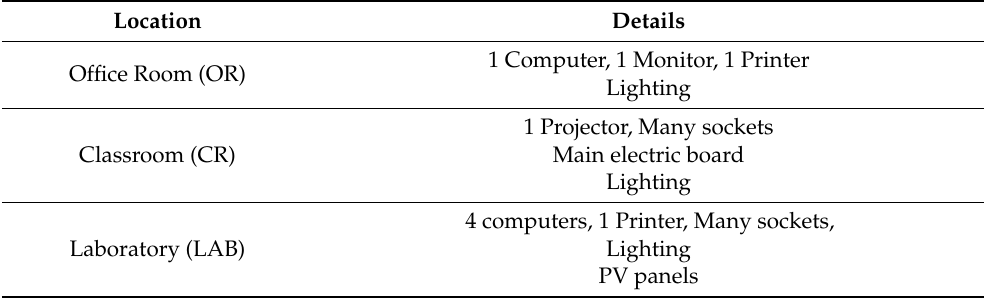
Table 3. List of sensors and measuring devices used for the testbed. Layer